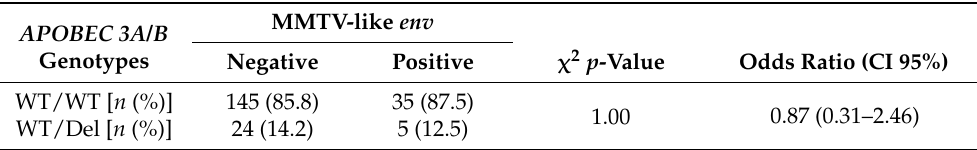
Table 1. Association between APOBEC3A/B genotypes and detection of MMTV-like env gene in BC samples.